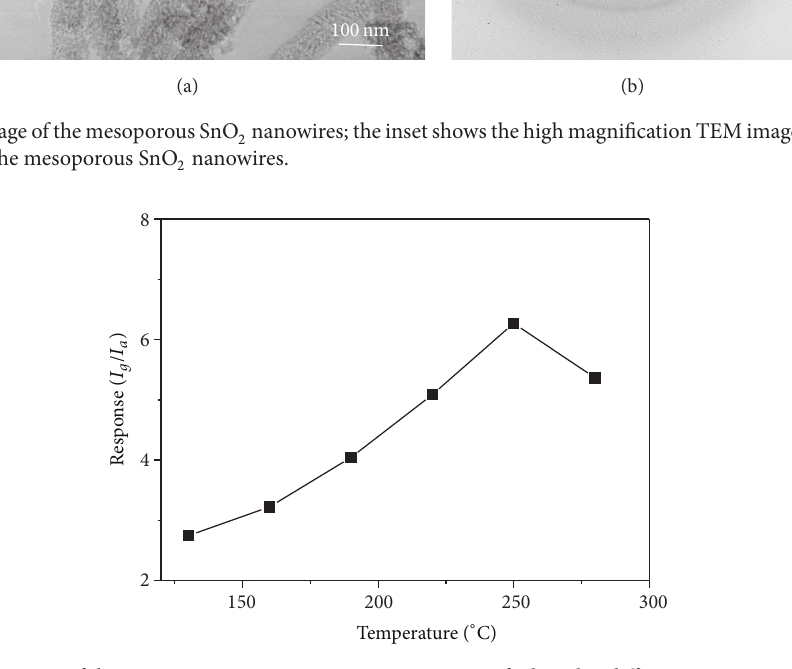
Figure 4: Responses of the mesoporous SnO 2 nanowires to 100ppm of ethanol at different operating temperatures.